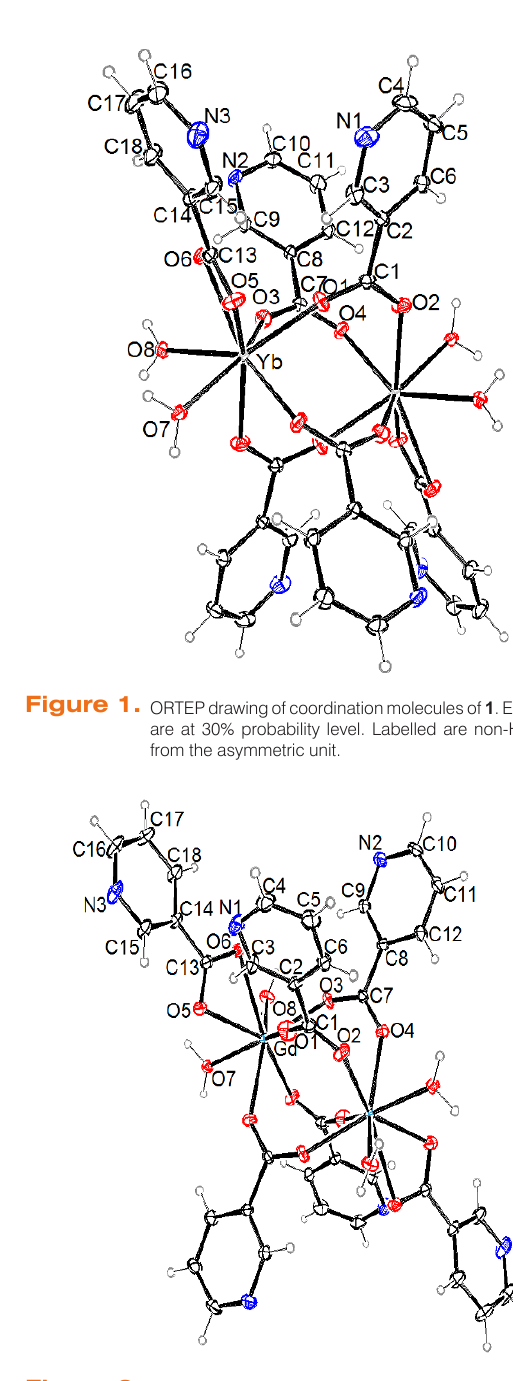
Figure 2. ORTEP drawing of coordination molecules of 2 . Ellipsoids are at 30% probability level. Labelled are non-H atoms from the asymmetric